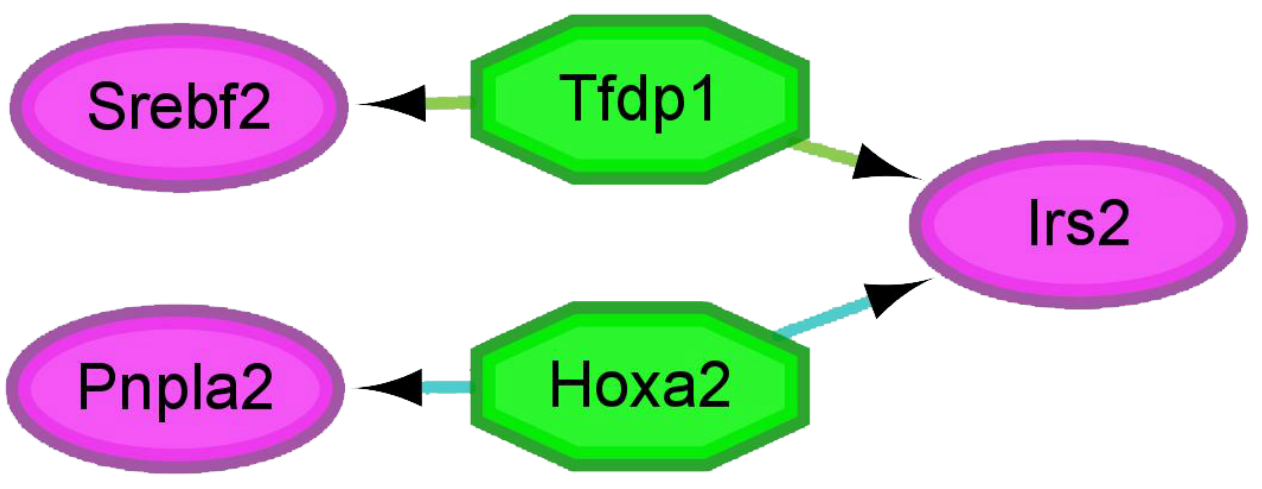
Figure 6. Transcription factor target network for NES > 5 using the iRegulon plug-in. The green octagonal node represents the predicted transcription factor. Pink oval nodes represent genes regulated by transcription factors.